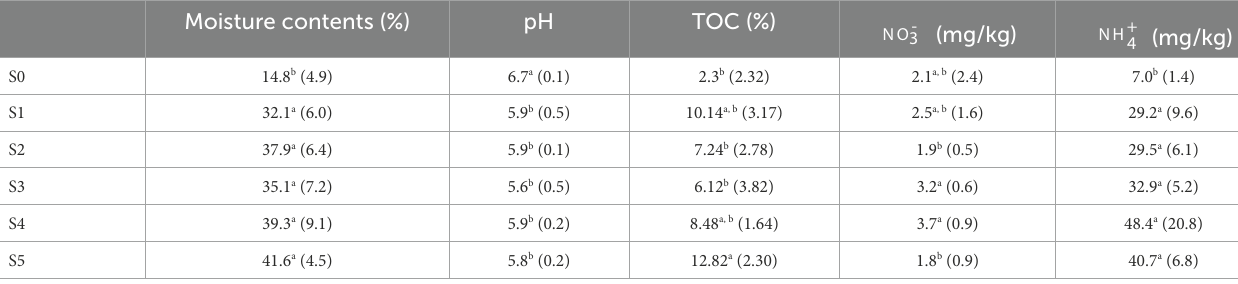
TABLE 2 Soil physiochemical properties investigated in this